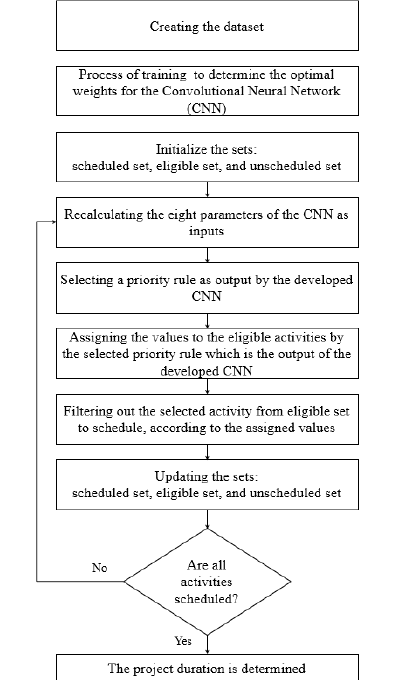
Fig. 2. The flowchart shows the explained algorithm. The process starts with training based on the created dataset and continues with scheduling all project activities to determine the final project